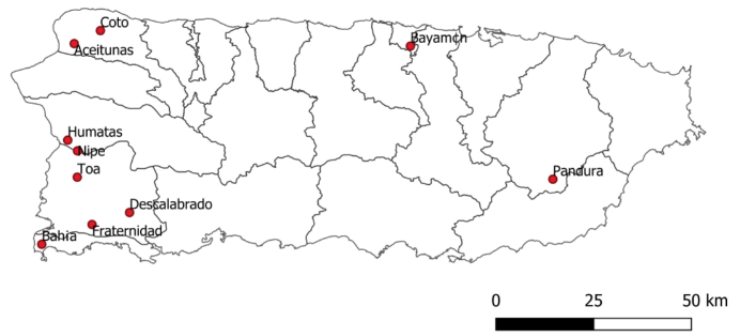
Figure 1. Map of the island of Puerto Rico showing locations of pedons.